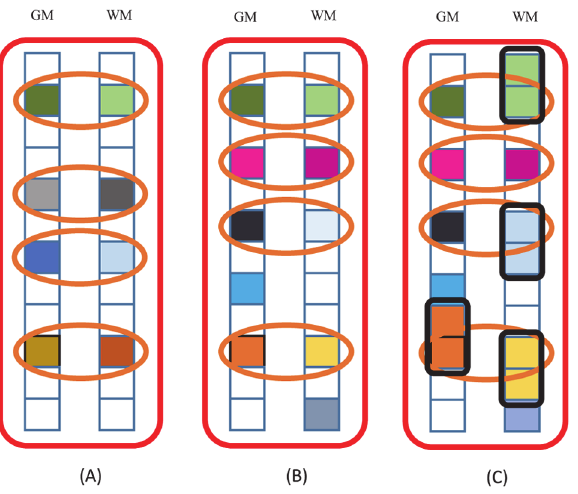
Fig 2. Comparison of weight coefficient matrices for three different feature selection methods. Each colored square corresponds to a non-zero element after feature selection. Circled squares (with the yellow ellipse outlines) correspond to the selected group-wise features, and circled squares (with black rectangle outlines) correspond to the selected pair-wise correlated features. (A) Group lasso. (B) Traditional dirty model. (C) The proposed extended dirty